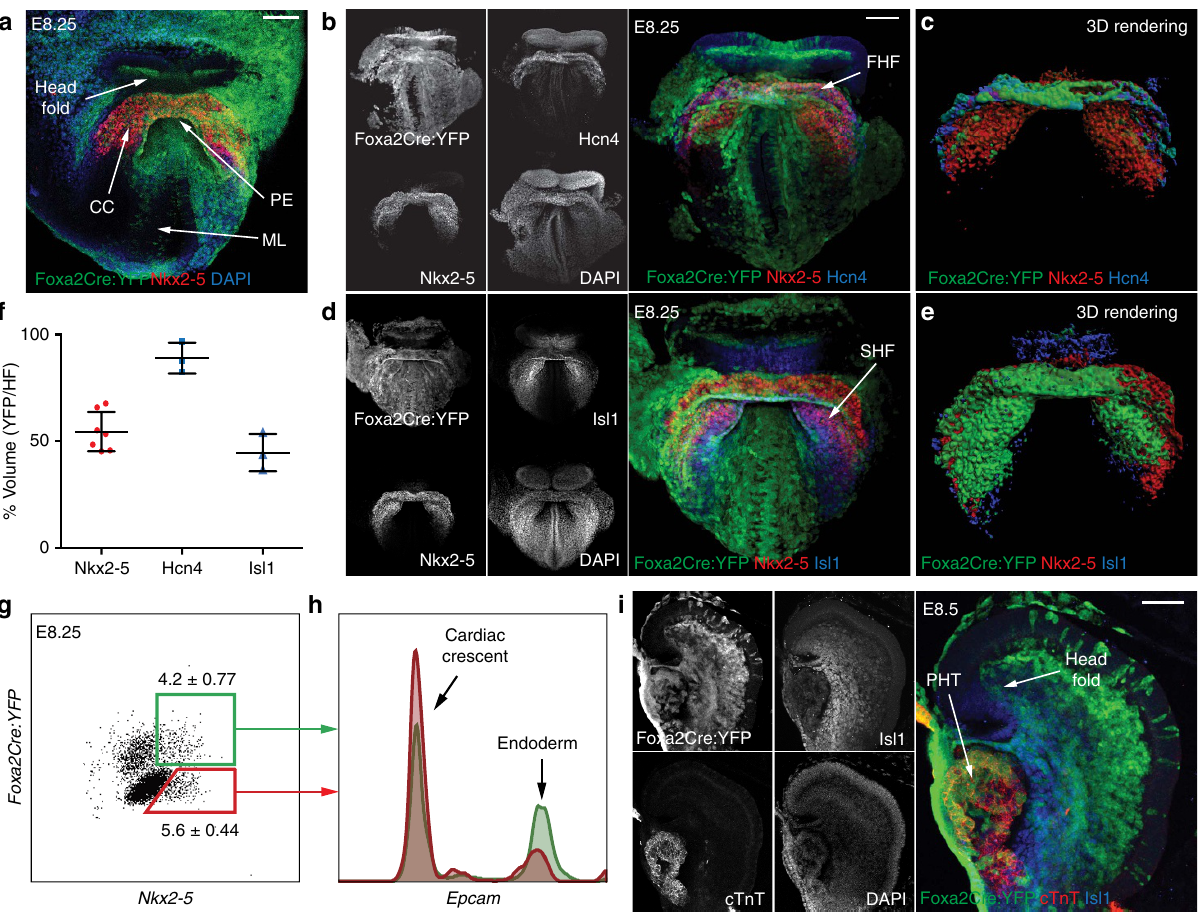
Figure 4 | Foxa2-vCPs contribute to the FHF and SHF during heart morphogenesis. ( a ) Confocal z -projection of E8.25 Foxa2Cre:YFP embryos analysed by WMIF using antibodies against YFP and Nkx2–5. ( b – e ) WMIF analysis of E8.25 Foxa2Cre:YFP embryos with antibodies against Hcn4 ( b ) or Isl1 ( d ), and three-dimensional (3D) surface renderings of the CC region as generated with Imaris software ( c , e ). Representative stage-matched embryos are shown. ( f ) Quantification of the volume of the 3D surface rendering showing the YFP volume as a percentage of the total CC (Nkx2–5), FHF (Hcn4) or SHF (Isl1). Error bars reflect s.d. ( g ) Flow cytometric analysis of dissociated E8.25 Foxa2Cre:YFP embryos with antibodies against Nkx2–5. ( h ) Analysis of Nkx2–5 þ YFP þ and Nkx2–5 þ YFP (cid:2) cell based on Epcam expression. ( i ) WMIF analysis of E8.5 Foxa2Cre:YFP embryo with antibodies against Isl1 and cTnT. CC, cardiac crescent; FHF, first heart field; ML, midline; PE, pharyngeal endoderm; PHT, primitive heart tube; SHF, second heart field. Scale bars, 100 m